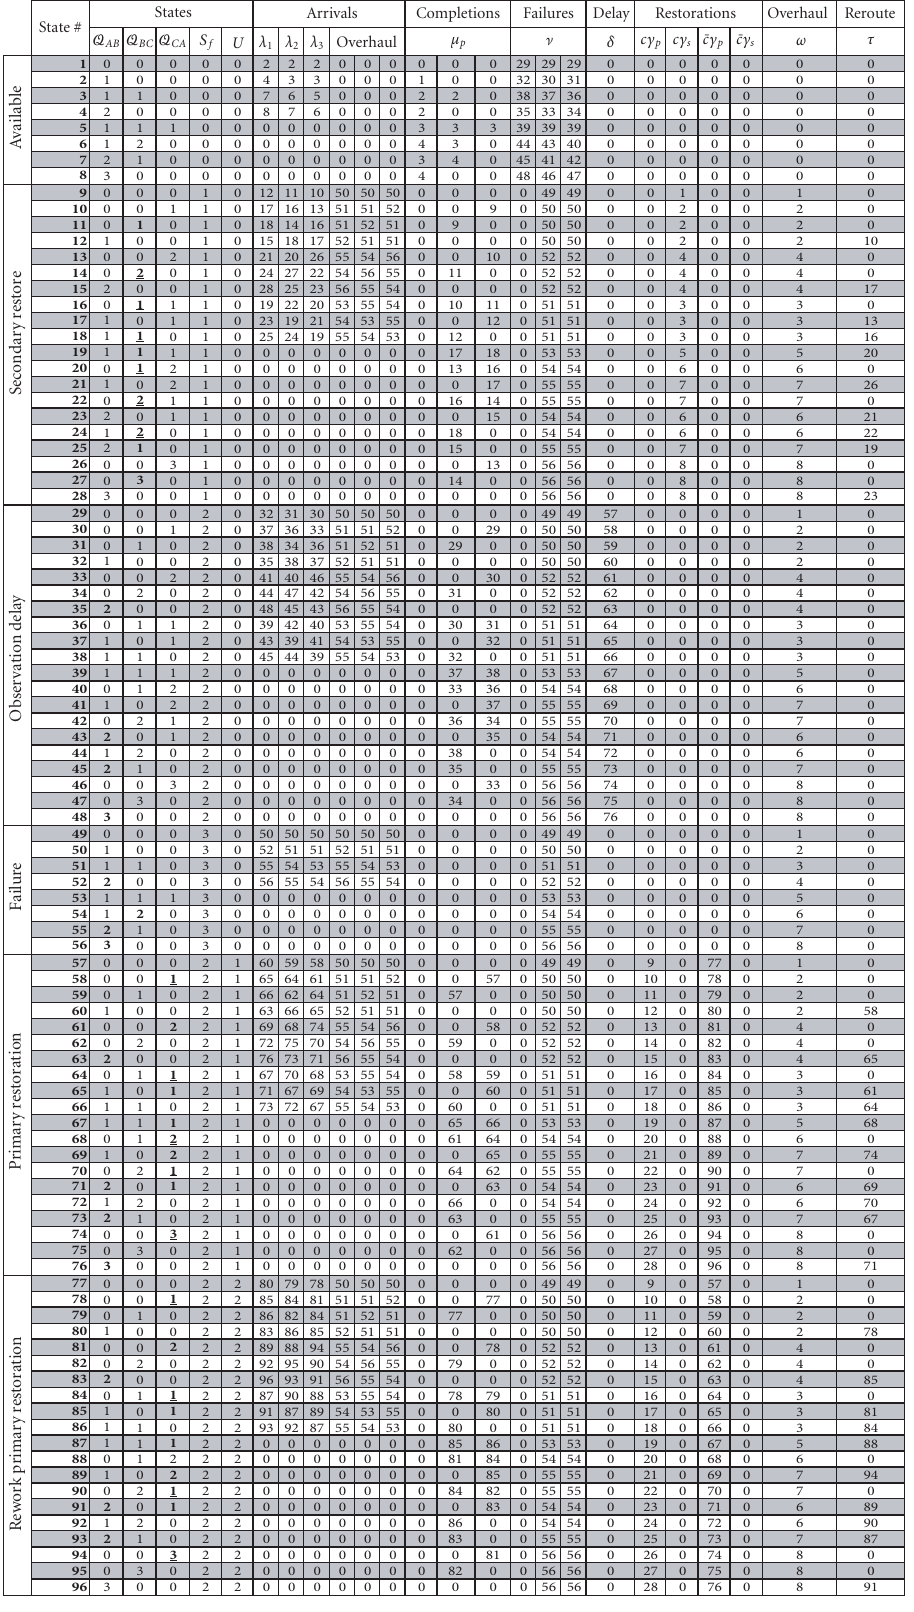
Figure 8: Transitions and transition rates of the uncertain database state